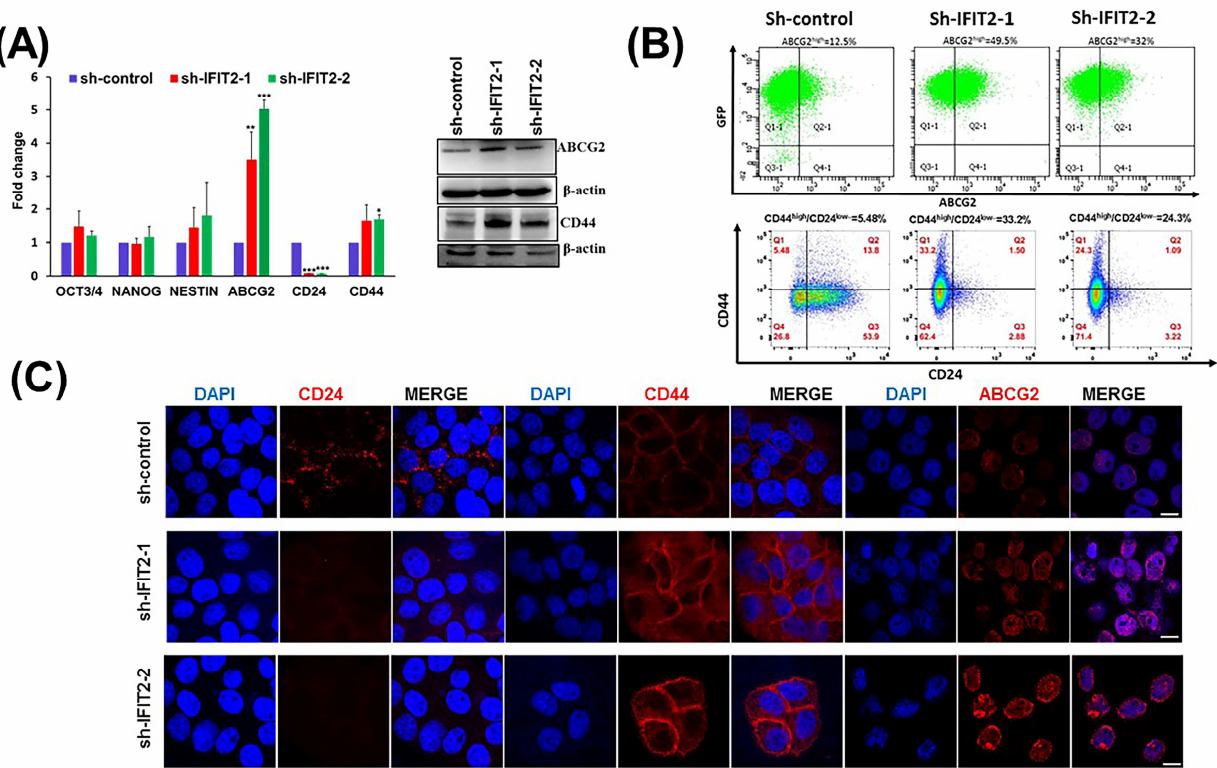
Figure 2. Expression of CSC markers in IFIT2 knockdown cells. ( A ) The mRNA expression levels of CSC markers in sh-control and stable IFIT2 knockdown cells were determined by Q-PCR, while the protein levels were analyzed by Western blotting. GAPDH was used as an internal control in Q- PCR and β-actin was used as an internal control in Western blotting; ( B ) Representative flow cytom- etry analysis of ABCG2, CD44, and CD24 in sh-control and IFIT2-depleted cells. Experiments were performed four times; ( C ) Representative image of immunofluorescence of ABCG2, CD44 and CD24 staining in sh-control and stable IFIT2 knockdown cells. Rhodamine-conjugated secondary anti- body for ABCG2, CD24 and CD44 (red) were applied, and nuclei were counterstained with DAPI (blue). Scale is 10 µm. The symbols *, ** and *** indicate statistically significant differences compared to sh-control at p < 0.05, p < 0.01 and p < 0.001, respectively.